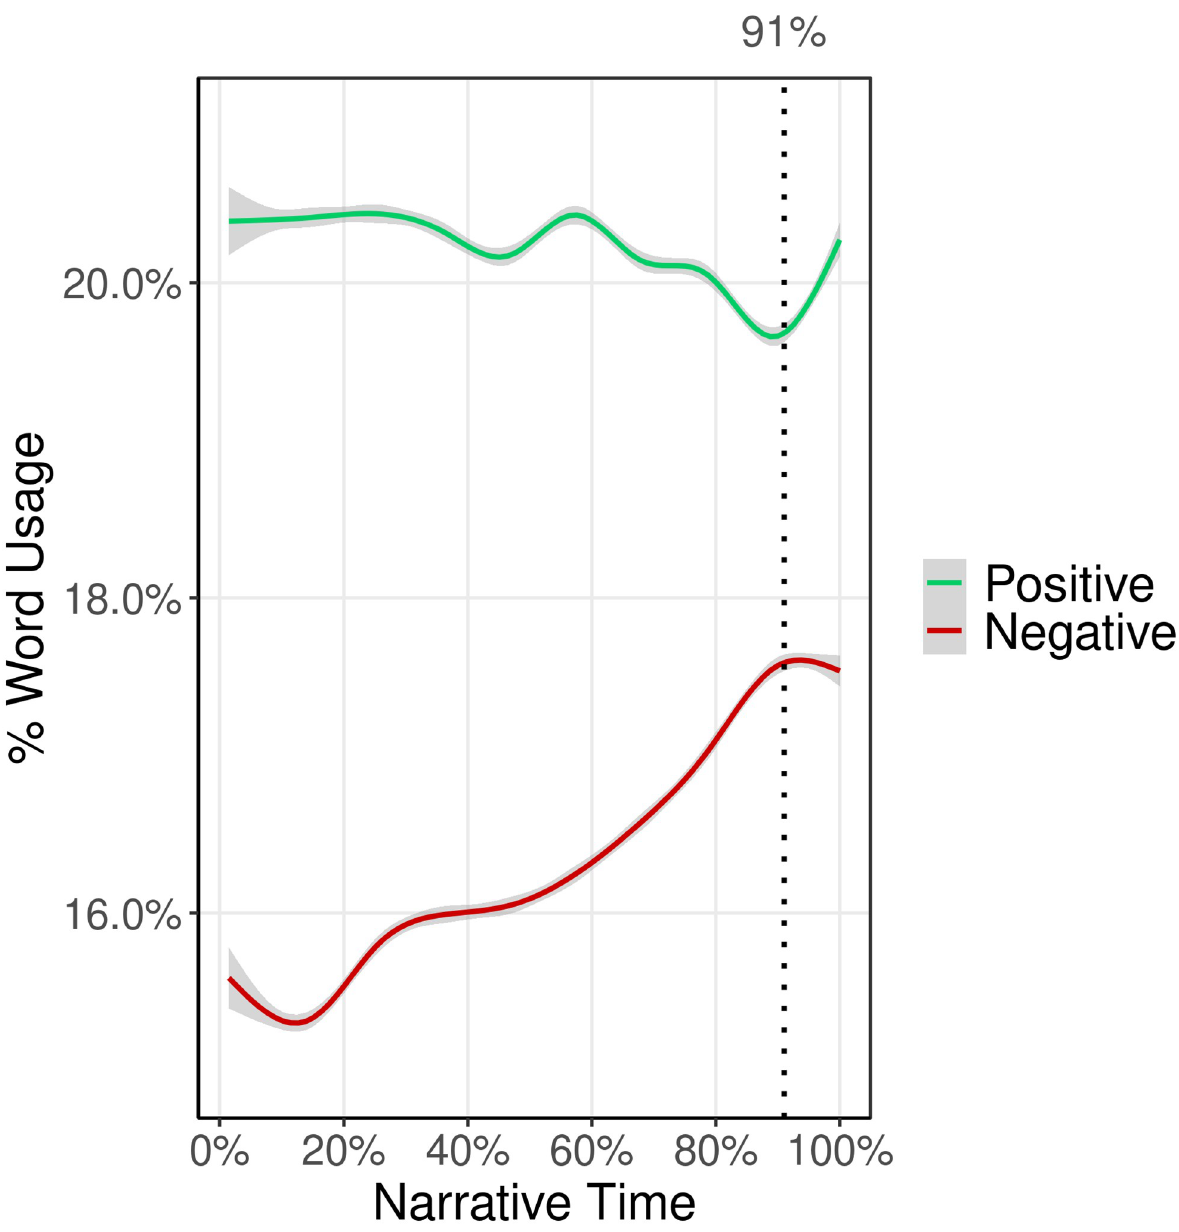
Fig 6. Average trends in proportion of positive and negative word usage by characters across narrative time. Vertical dotted line shows location of peak negative density and lowest positive density. Grey band is the 95% confidence interval around the estimated mean. n = 965,147 words.